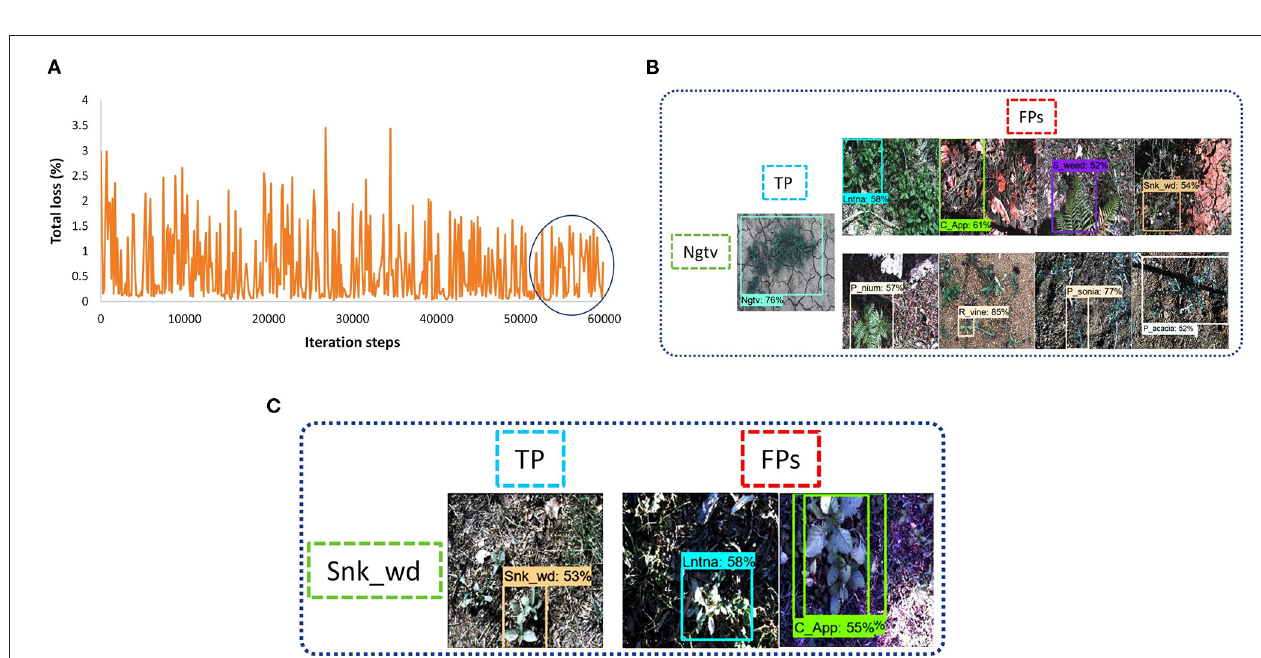
FIGURE 8 | Performance of the Region-based fully convolutional network (RFCN) model: (A) total loss plot; (B) false-positive results for the negative class; (C) false-positive results for the snakeweed class.